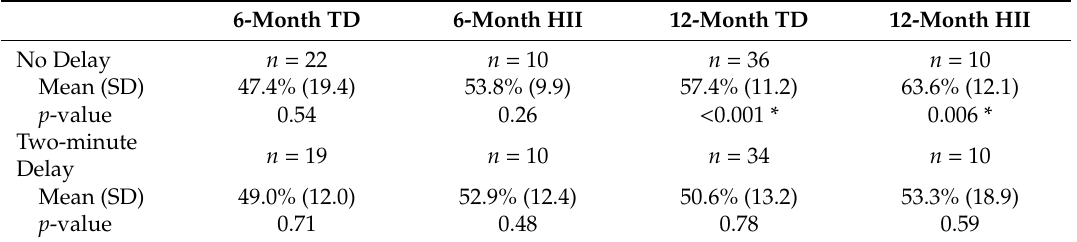
Table 2. Percentage of time on novel face in TD and HII at 6 and 12 months for visual paired comparison.